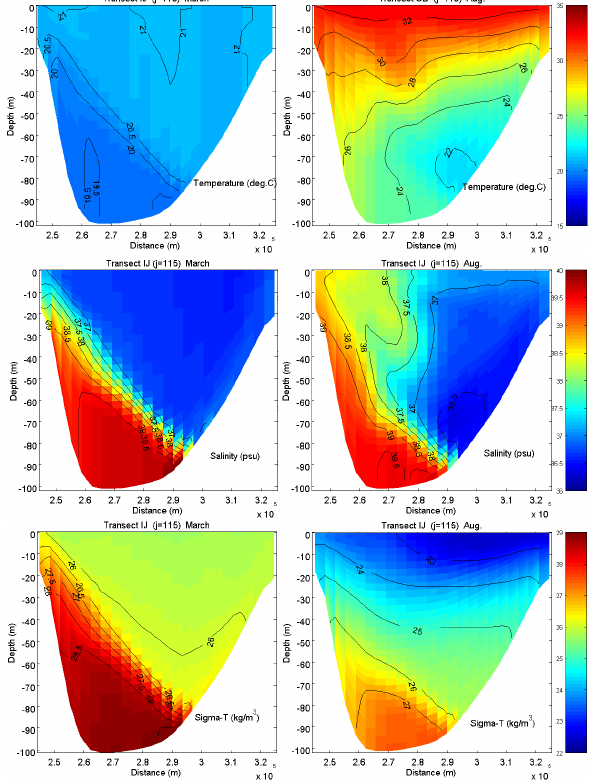
Fig. 11. Cross-section of the mean temperature, salinity and σ - T along IJ path, shown in Fig. 5 obtained from model simulation during March (left) and August